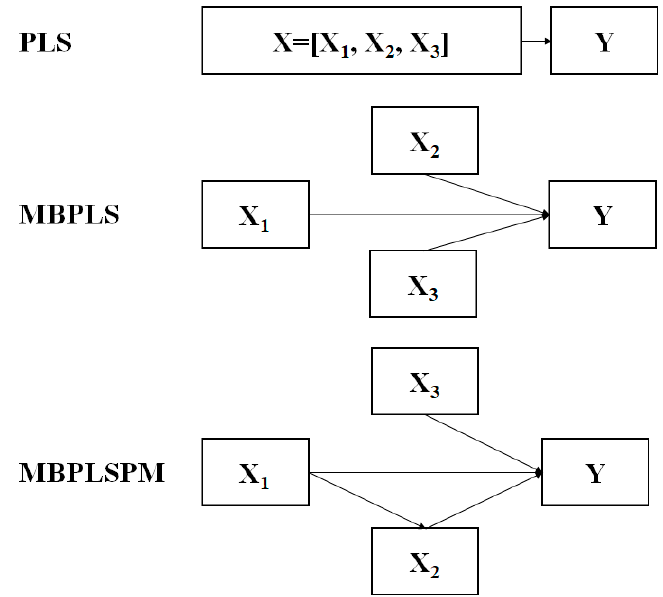
Figure 3. The schematic diagram of the partial least squares (PLS), multi-block partial least squares (MBPLS), and multi-block partial least squares path model (MBPLSPM) algorithm.